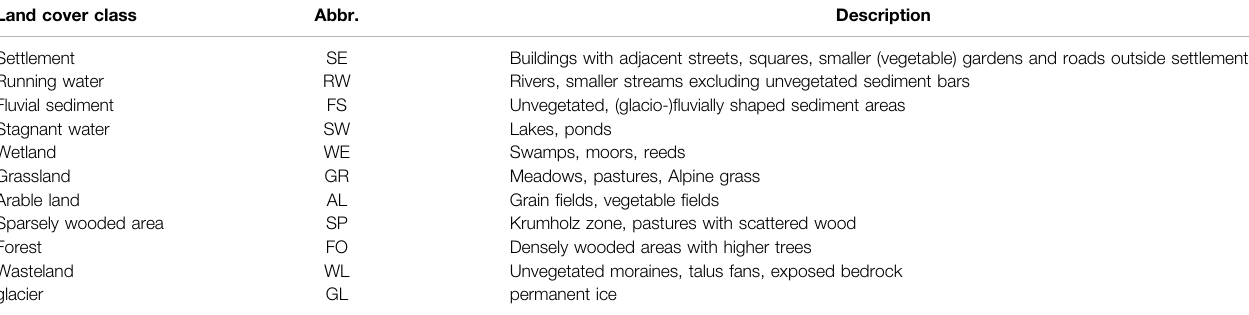
TABLE 3 | Land cover classes de fi ned based on the historical and current basic data. Land cover class